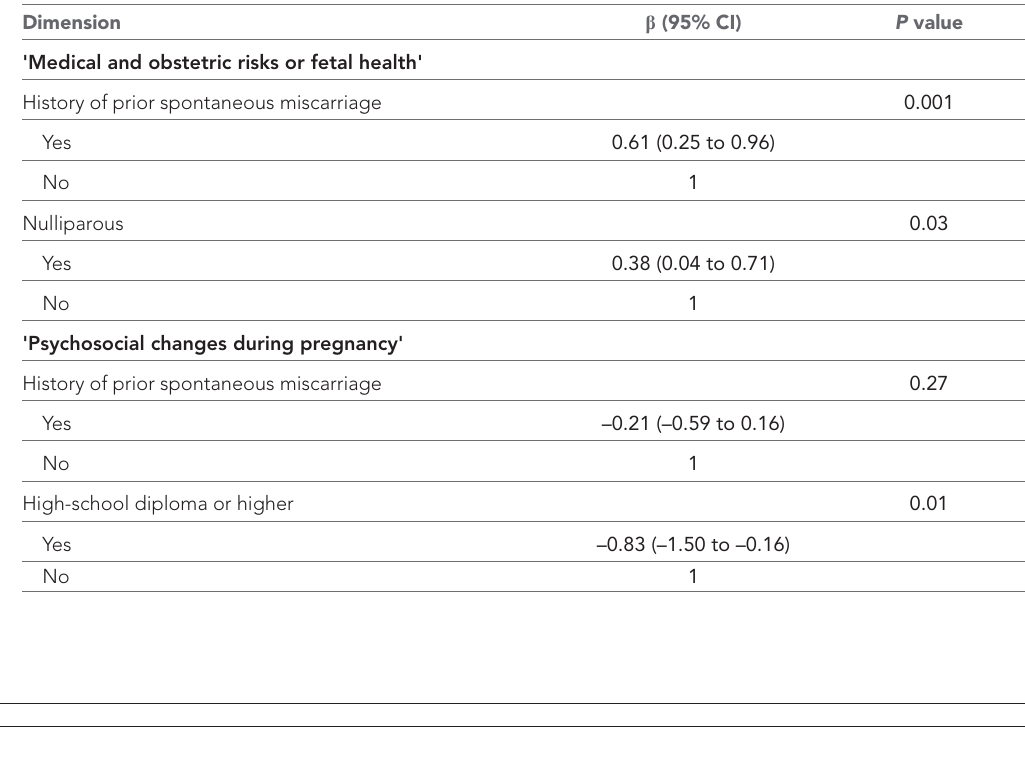
Table 4 Multivariate analysis of the factors associated with maternal stress among pregnant women (in the first trimester of pregnancy) as evaluated by the Antenatal Perceived Stress Inventory